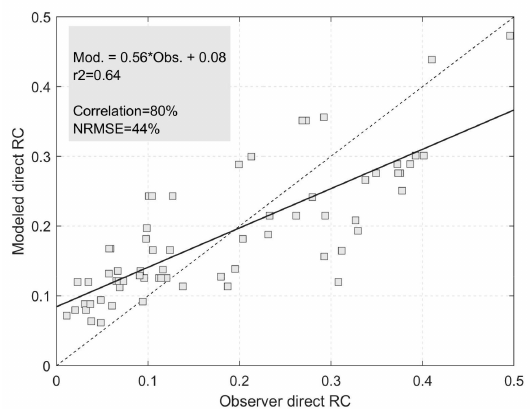
Figure 5. Scatter plot of modeled and observed direct runoff coefficient (RC) values in marginal sub-basins. By pristine validation gauges data which were not involved in the calibration process, the NRMSE of validation obtained 0.41, which is close to the calibration error, indicating success of the calibration process. In Table 7, the main rivers in Lake Urmia basin are listed in descending order of observed runo ff . The last column on the right shows the di ff erence between the observed and modeled values divided by the observed value. As can be seen, for most of the rivers providing higher discharge to the lake, the error was less than 50%. For the major rivers, Gadarchay, Mahabad, Rozechay, and Simineroud, the accuracy is higher. The highest error was found for the Zulachay river basin, which was due to lower value of observed direct runo ff (smaller fraction denominator). The mean of validation gauges for modeled values obtained 0.19 and that of the observation was 0.16 and correlation between observed and modeled values obtained